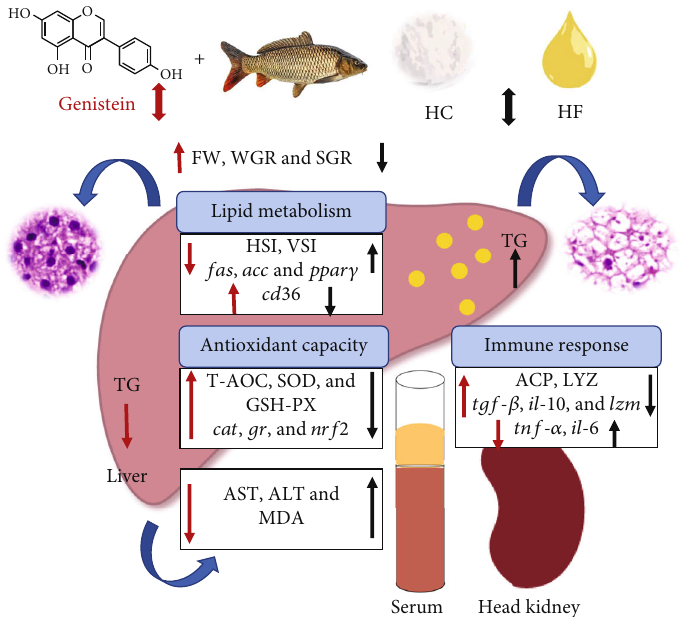
Figure 7: Summary